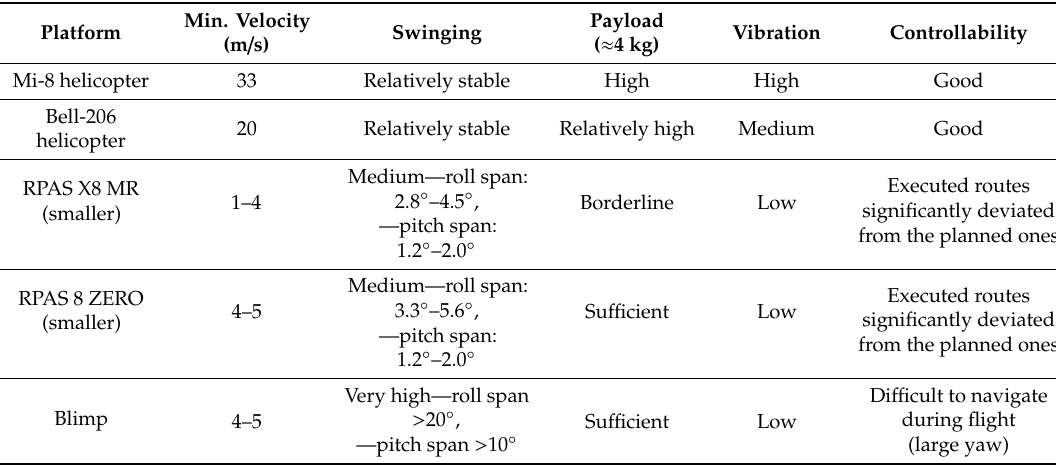
Table 2. Summarized results of tests performed in di ff erent operational conditions for the following platforms: Mi-8 and Bell-206 helicopters, RPAS X8 MR, RPAS 8 ZERO, and a blimp with hyperspectral line scanner V9, multirotor UAV with hyperspectral frame sensor UHD-185.